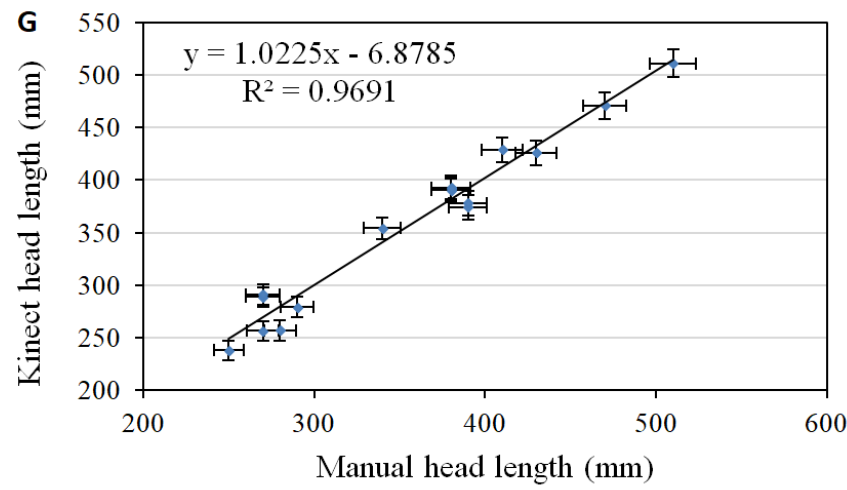
Figure 4. Assessment between different cow body parameters: ( A ) hip distance, ( B ) body length, ( C ) average height, ( D ) slope, ( E ) chest girth, ( F ) depth, and ( G ) head length. In the axis labels, “Manual” and “Kinect” refer, respectively, to manual and Kinect measurement.